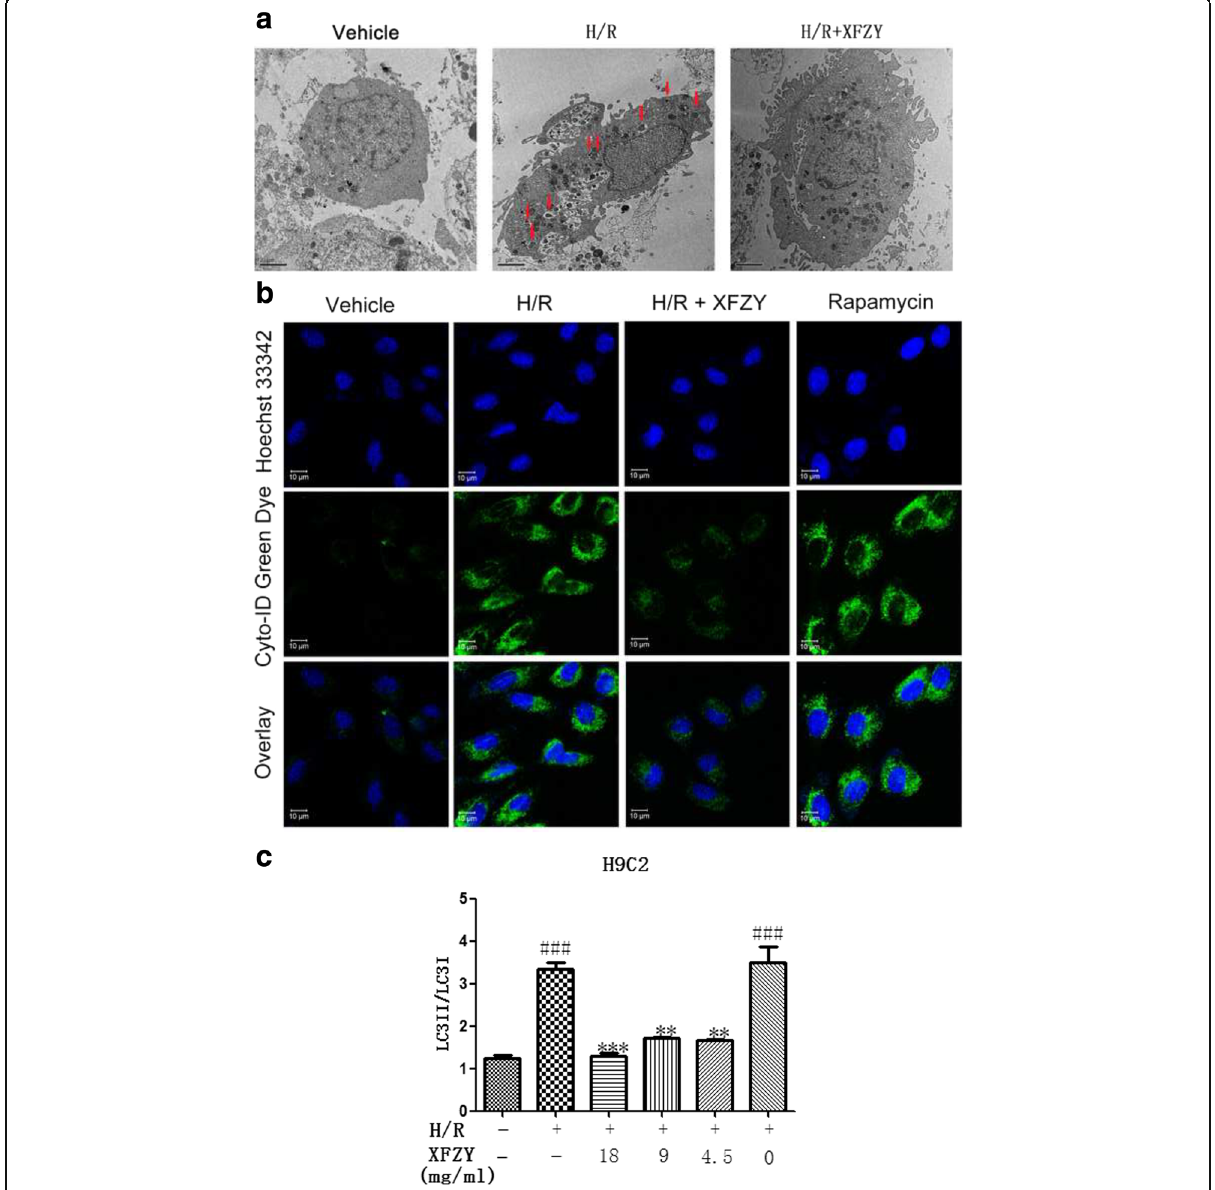
Fig. 6 Effect of XFZY on H/R-induced autophagy in H9C2 cells. a Ultra-structural changes in H9C2 cells after H/R by transmission electron micros- copy (10,000×). b Autophagic vacuoles were analyzed by confocal microscopy. Cells were plated in cell culture dishes with a glass bottom. After XFZY treatment, cells were concurrently stained with Cyto-ID Green dye and Hoechst33342 and detected by confocal microscopy. c Protein expression of LC3-II was determined by Western blot. The results were expressed as mean ± SD. ***p < 0.001, **p < 0.01 vs H/R group; ### p < 0.001 vs Vehicle